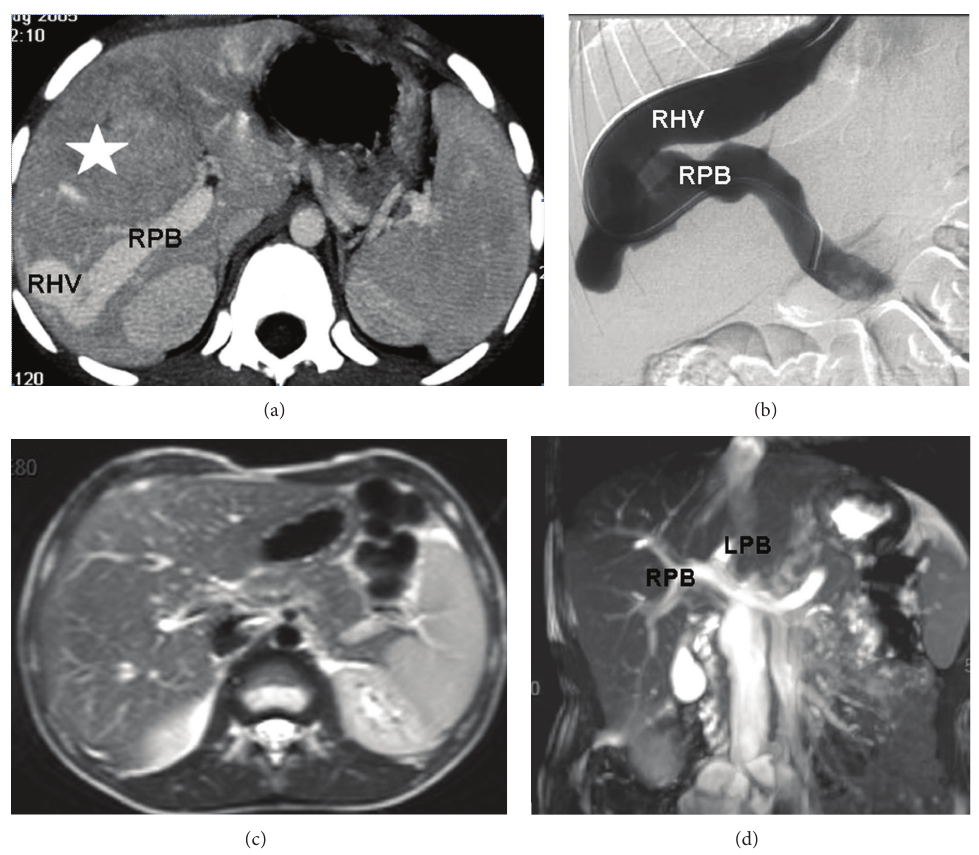
Figure 2: Six-year-old boy with a congenital portohepatic shunt complicated by a biopsy-proven FNH measuring 7cm diameter (white star). (a)Contrast-enhancedCTscanatdiagnosisshowsanabnormalandlargecommunicationbetweentherightportalbranch(RPB)andtheright hepatic vein (RHV). (b) Phlebography with opacification of the shunt between the RPB and the RHV. Closure of the shunt was performed by interventional radiology. (c) MRI performed seven years later shows the disappearance of FNH on the T2-weighted images. No enhancement was present at the arterial phase after gadolinium injection (not shown). (d) Note the normal aspect of the portal bifurcation (RPB and left portal branch (LPB)) on coronal MIP reconstruction of the T2-balanced